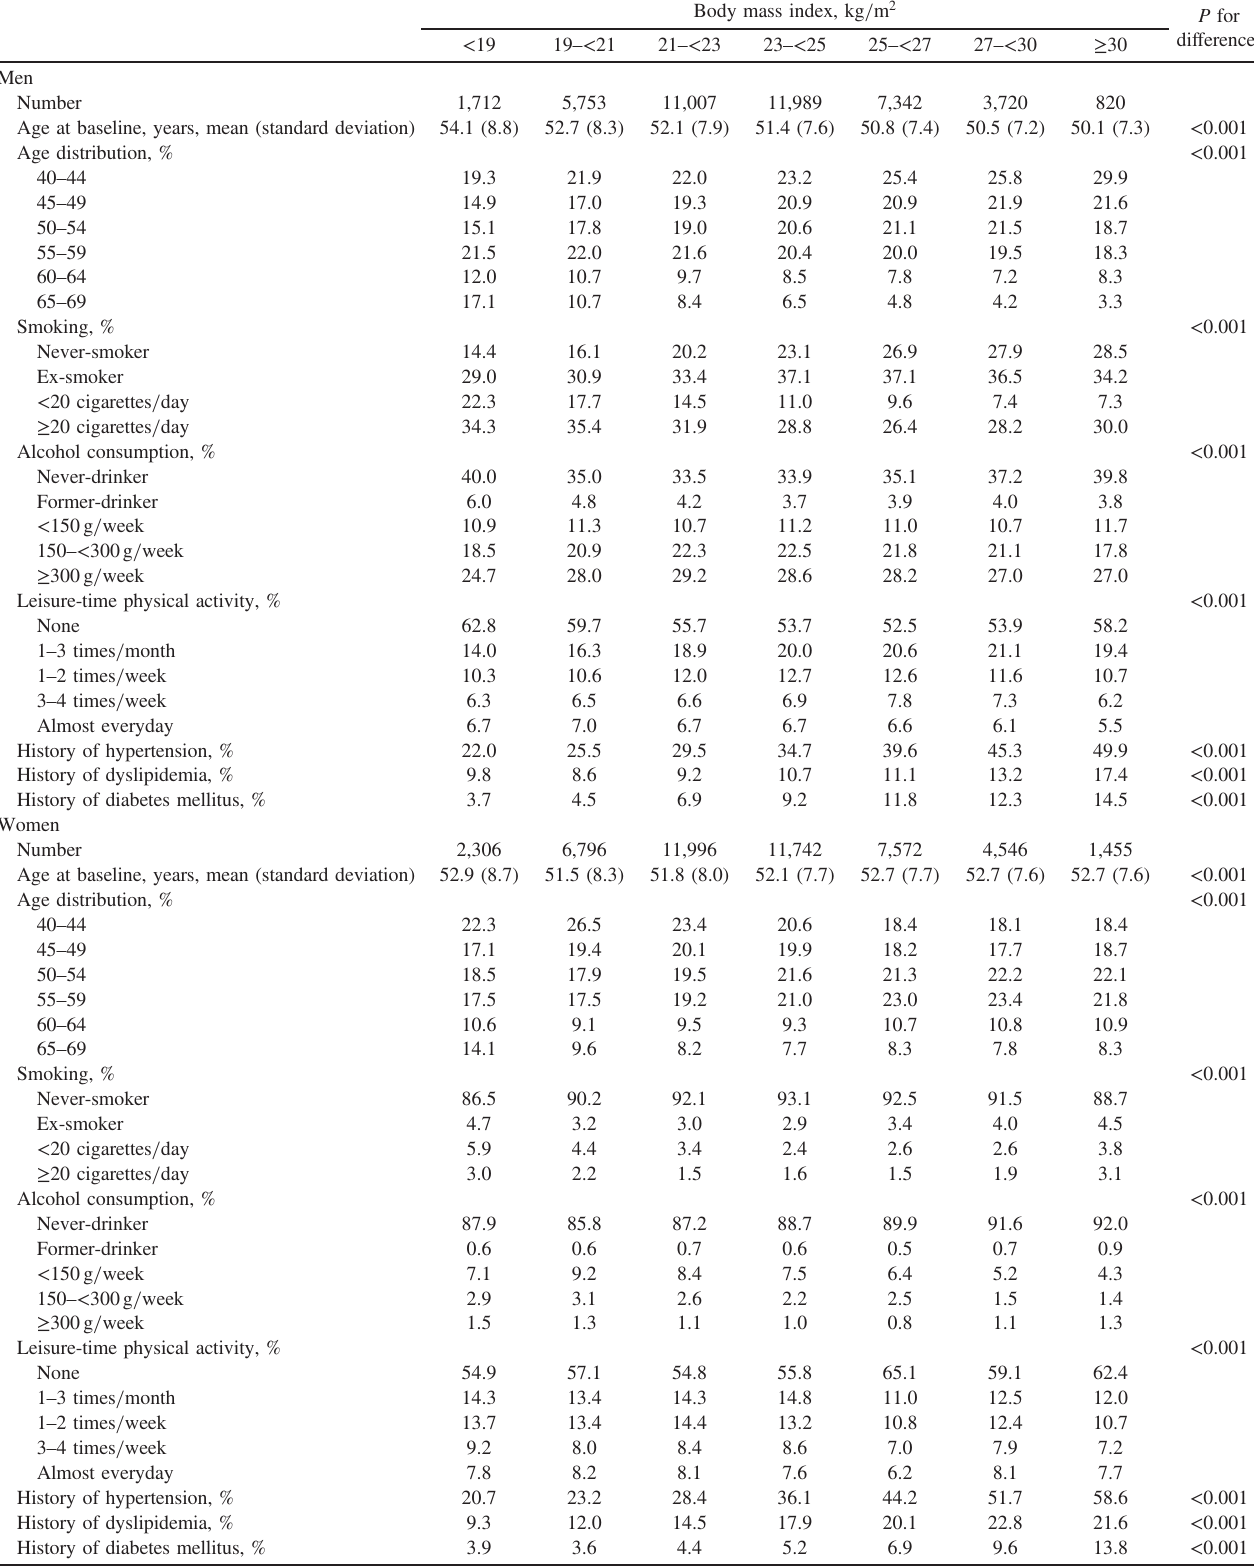
Table 1. Means and proportions of updated lifestyle and medical histories according to categories of cumulative average body mass index